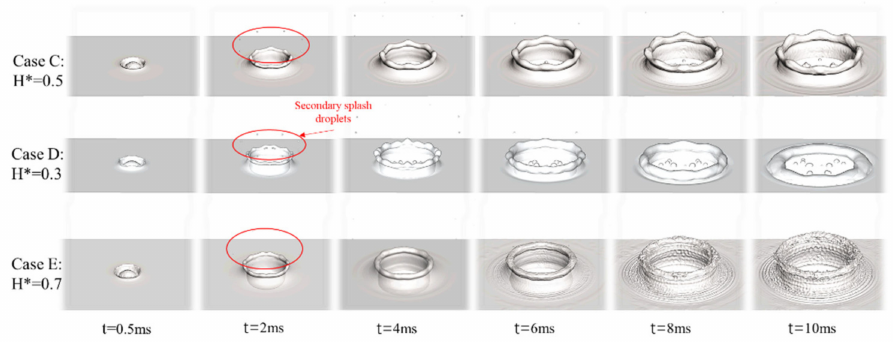
Figure 9. The three-dimensional evolution of the droplet impacting on the film at different times for case C, D, and E.